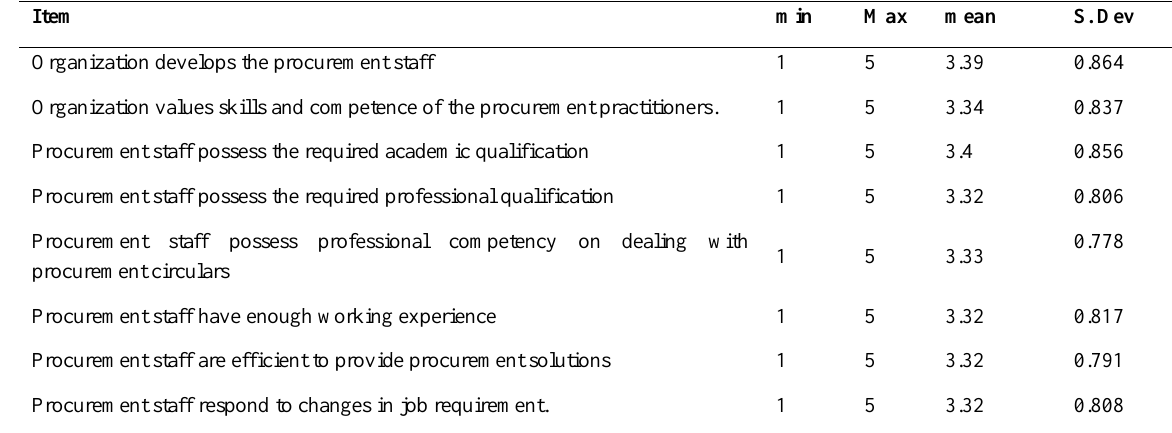
Table 2: Staff Competence on Procurement Performance